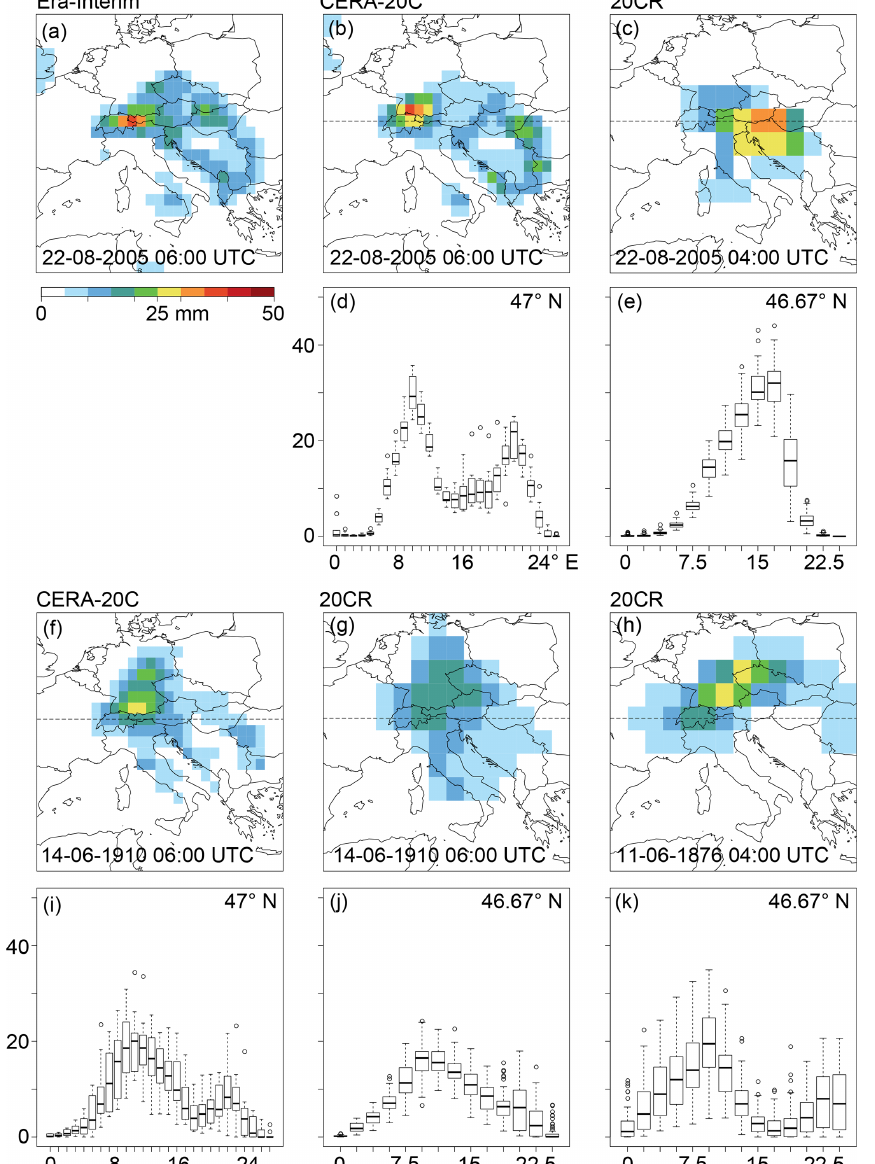
Figure 2. Daily precipitation totals (mm per 24h; color shade) as calculated for 22 August 2005 (a–c) , 14 June 1910 (f, g) , and 11 June 1876 (h) from ERA-Interim (a) , CERA-20CR (b, f) , and 20CR (c, g, h) . Slightly differing time steps are due to differing tem- poral resolutions of the reanalyses products. Boxplots below the map panels show, respectively, and where applicable, the variability of daily precipitation totals of all ensemble members in grid boxes along cross sections at 47 ◦ N (CERA-20C; d and e ) or 47.67 ◦ N (20CR; e , j , and k ). The horizontal lines in (b, c, f, g, h) delineate these cross